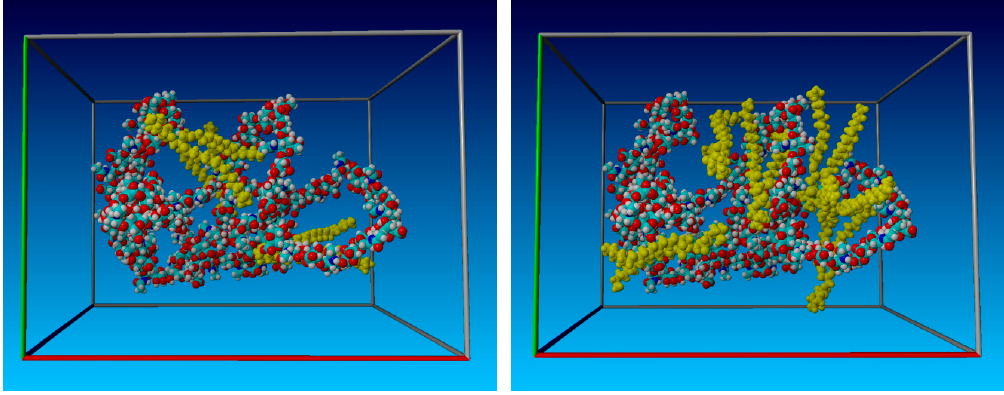
Figure 17. The initial simulation box configuration containing a single HA chain and three ( Left ) and seven ( Right ) particles of the DPPC. The HA chain is partially folded to reduce the total number of atoms; and, for better visualization, the water molecules are not shown. DPPC particles are yellow. Throughout the simulation, the total number of atoms remained constant. The simulation began